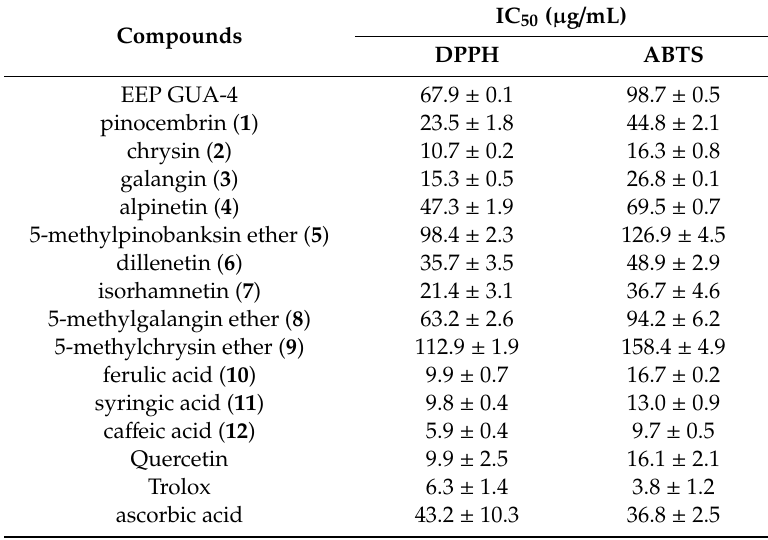
Table 2. Scavenging ability of ethanol extract of propolis (EEP) GUA-4 and compounds 1 – 12